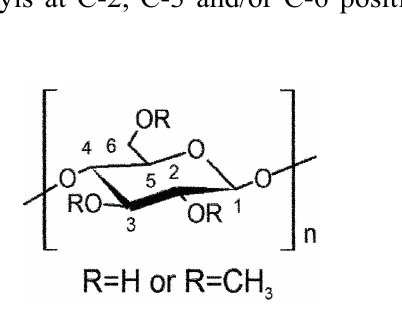
Figure 1. Repeating unit of methylcellulose: –OH or –OCH 3 at positions 2, 3 and 6 of the anhydro- D